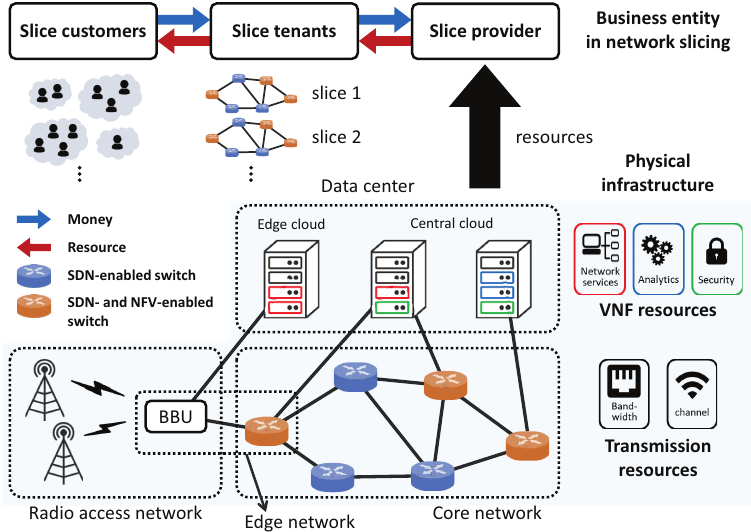
Figure 1. Business entities and shared resources in network slicing